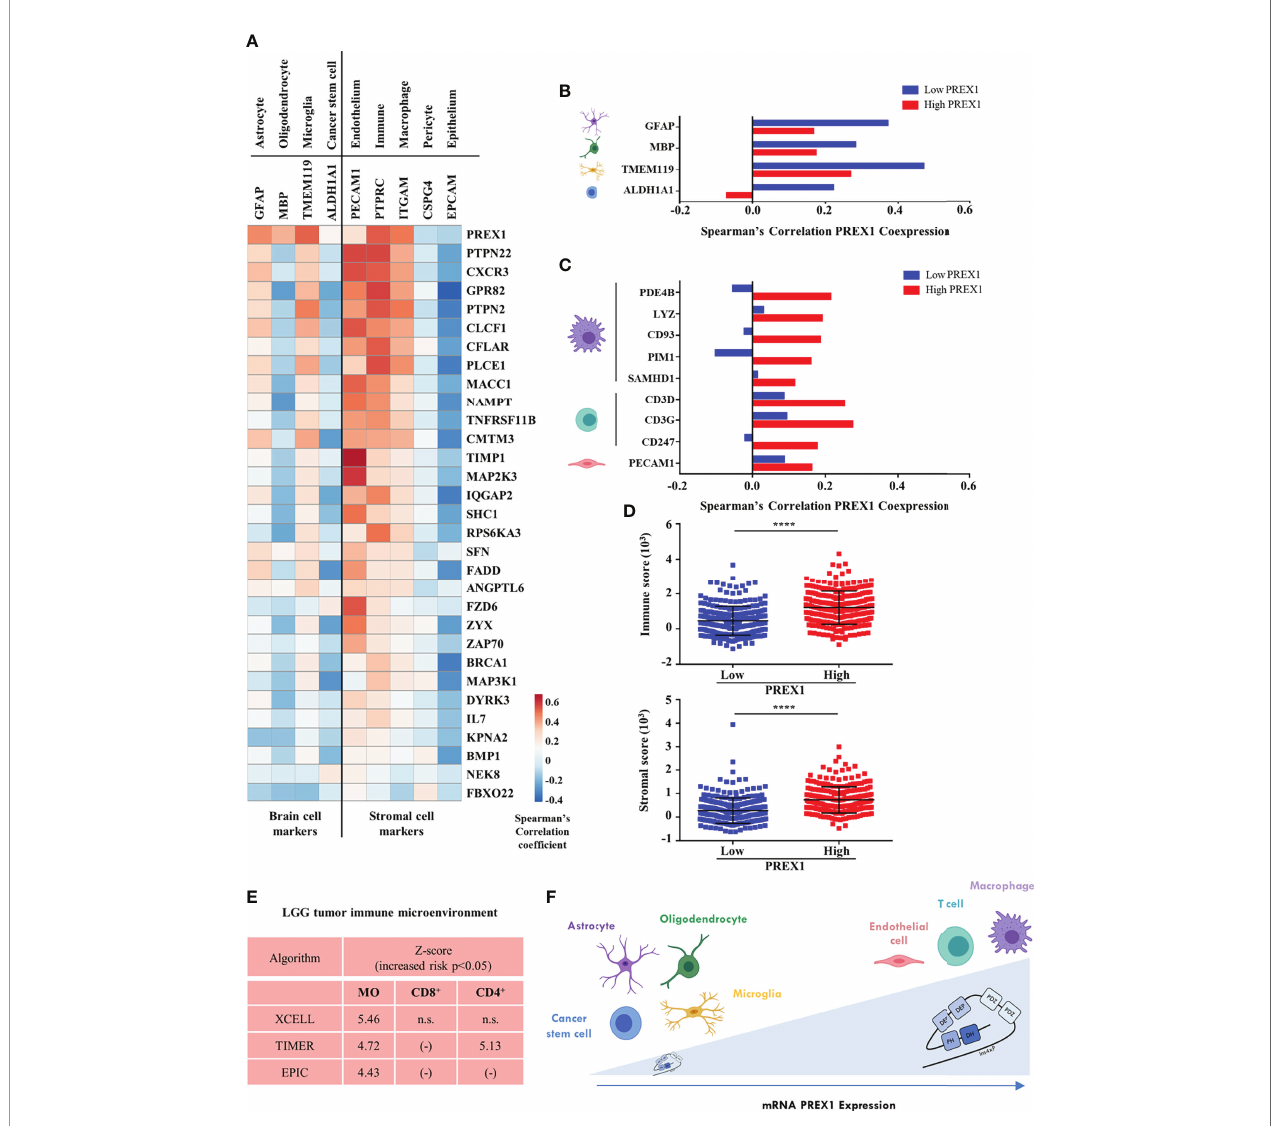
FIGURE 6 | P-Rex1 signaling partners correlate with markers of the cell stroma in LGG tumors. (A) Coexpression of genes of the PREX1 signaling hub signature with markers of different cells within the LGG tumor microenvironment. Blue and red colors indicate the Spearman ’ s correlation coef fi cient scale from negative to positive values. (B) Coexpression of PREX1 with cell markers of astrocyte, oligodendrocyte, microglial and cancer stem cells in the low and high PREX1 expression subsets. (C) Coexpression of PREX1 with markers of macrophage, T cell and endothelial cells in the low and high PREX1 expression subsets. (D) Immune and stromal scores, predicted by the ESTIMATE algorithm, in tumors of LGG patients divided by low and high PREX1 expression, ****p < 0.0001, t test. (E) Overall analysis of LGG tumor immune microenvironment as estimated by the indicated algorithms. Signi fi cant values indicative of the presence of macrophages (MO), and T lymphocytes (CD8 + and CD4 + ) are shown. Z-scores indicate an increased risk of shorter survival (p < 0.05), n.s., not signi fi cant. (F) Model depicting the LGG tumor microenvironment showing the presence of different cell types correlated with PREX1 expression (horizontal arrow). Tumors with higher PREX1 expression exhibit increased immune in fi ltration and